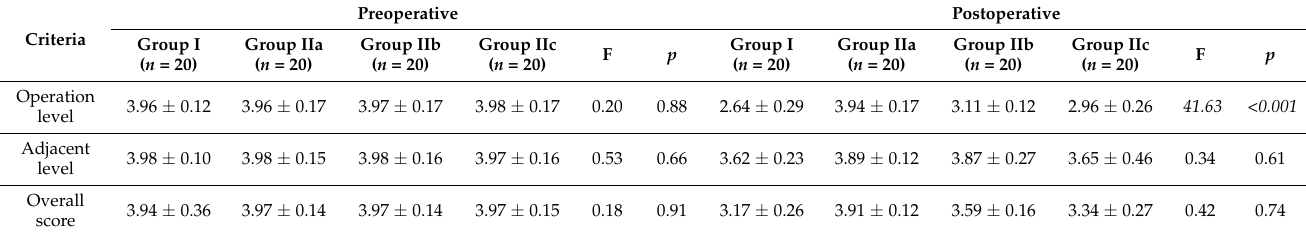
Table 3. Comparison of the image quality according to the Jarvik 2000 [12]